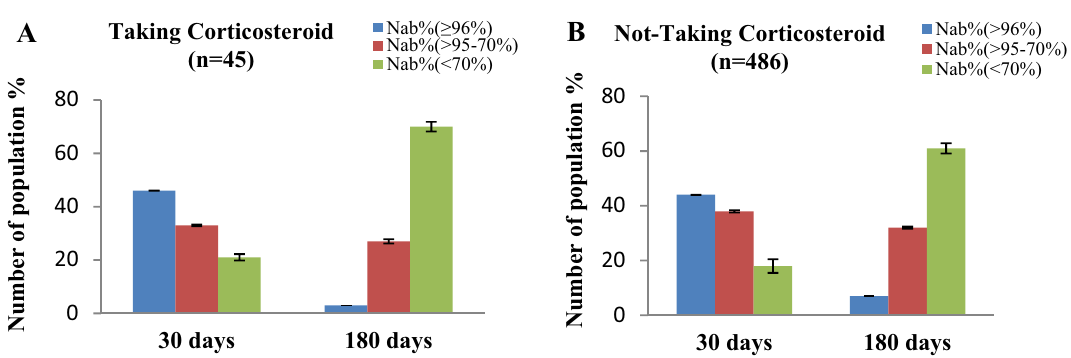
Figure 5. Percentage (%) of people with immune responses in ( A ) the Corticosteroid-taking group and ( B ) the non-Corticosteroid-taking group after 30 days and 180 days of completing 2nd